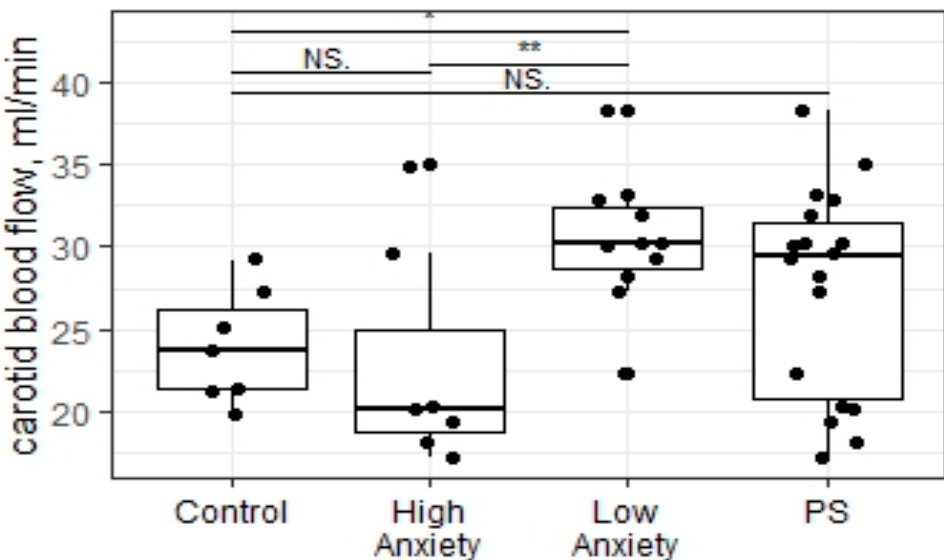
Figure 2. Carotid blood flow rate of PSS rats segregated into high- and low-anxiety groups according to AI as determined by performance in the EPM. Differences in blood flow rates among groups are shown as boxplots with dots representing individual data values and medians shown by horizontal lines. The boxes include the central 50% of the data, i.e., from the 25th to the 75th percentile. The whiskers include the data contained within 1.5 times the interquartile range. NS—non-significant, p > 0.05, * p < 0.05; ** p < 0.01. p values were determined in non-parametric analysis.